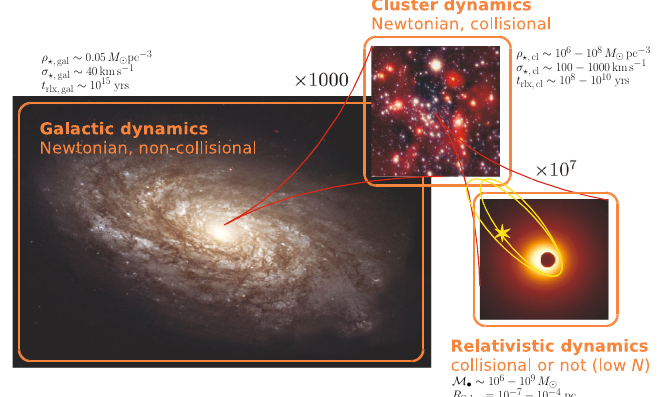
Fig. 6 On the left, and with the largest scale, the galaxy has an average density of stars of about 0 . 05 M (cid:2) pc − 3 . The velocity dispersion is ∼ 40km s − 1 . From these quantities one can infer that the relax- ation time in the vicinity of our Sun is t rlx ∼ 10 15 yrs. The upper panel shows the galactic nucleus that such a galaxy has. A typical size for it is ∼ 1 pc, the stellar density ranges between 10 6 − 10 8 M (cid:2) pc − 3 and the velocity dispersion is of σ ∼ 100 − 1000km s − 1 . In this region, t rlx ∼ 10 8 − 10 10 yrs. In the last panel, we have that the dynamics of the system is dominated by General Relativity. As a reference point, the Schwarzschild radius of a 10 6 M (cid:2) (10 9 M (cid:2) ) is 10 − 7 pc (10 − 4 pc)